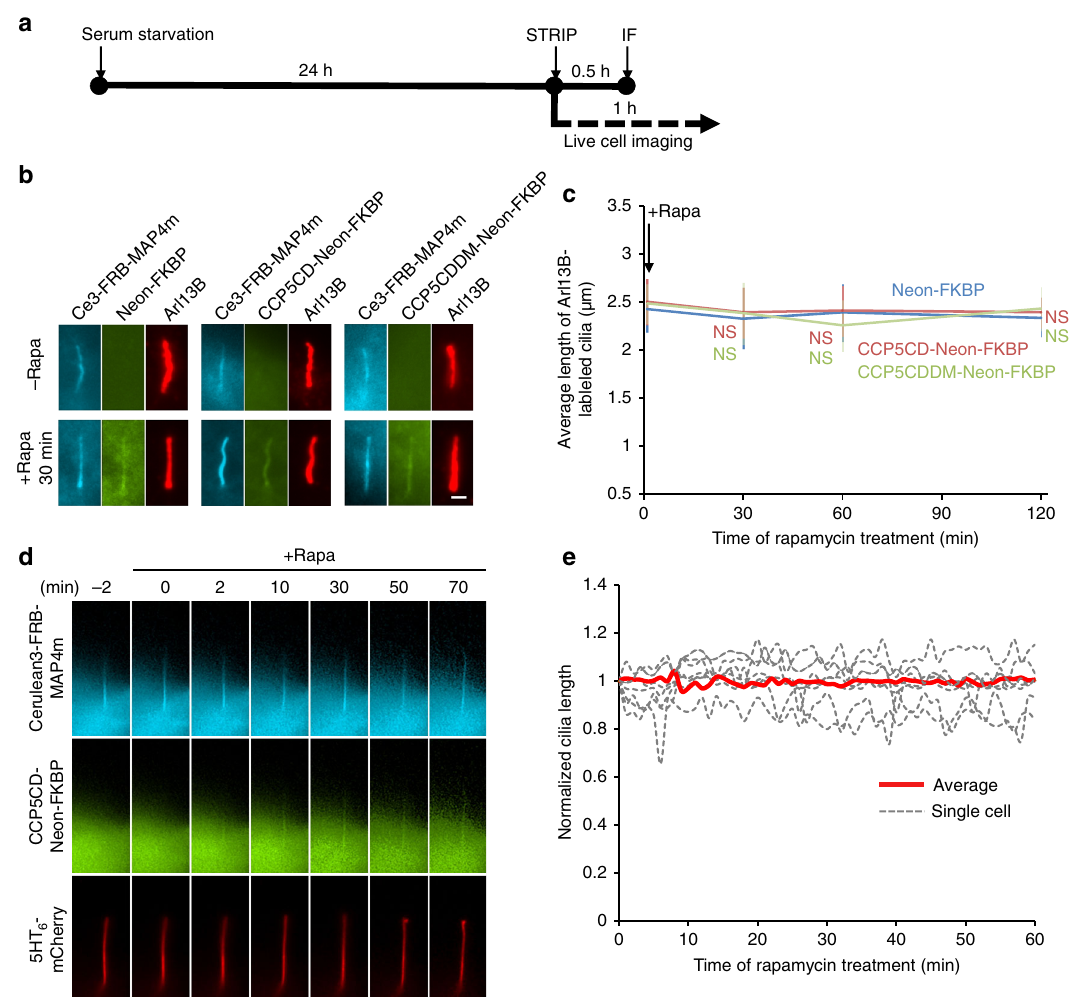
Fig. 2 Glutamylation is not required for cilia maintenance. a The experimental procedure for applying STRIP together with immuno fl uorescence staining (IF) in b or live-cell imaging in d after serum starvation-induced ciliogenesis. b , c Rapid deglutamylation does not affect ciliary length in the steady state. NIH3T3 cells were transfected with P2A-based constructs for co-expression of Cerulean3 (Ce3) – FRB – MAP4m and Neon-FKBP-tagged proteins. Transfected cells at 80 – 90% con fl uency were serum-starved for 24 h and then incubated with 100 nM rapamycin for the indicated times. The cilium length in cells expressing the indicated proteins was measured by labeling with anti-Arl13B antibody and quantifying before and after the addition of 100 nM rapamycin. Scale bar, 1 μ m. Data represent the mean ± s.e.m. ( n = 269, 282, and 238 cells for the Neon-FKBP, CCP5CD-Neon-FKBP, and CCP5CDDM-Neon-FKBP groups, respectively; 3 – 5 independent experiments). NS indicates no signi fi cant difference between the control (Neon-FKBP) and the indicated groups (Student's t -test). d The real-time morphology of the primary cilium during axonemal deglutamylation. NIH3T3 cells were cotransfected with CCP5CD-Neon-FKBP – P2A – Cerulean3 – FRB – MAP4m and a ciliary membrane marker, 5HT 6 – mCherry. Transfected cells at 80 – 90% con fl uency were serum-starved for 24 h and then incubated with 100 nM rapamycin for the indicated times. Video frames of a cell coexpressing the indicated proteins upon treatment with 100 nM rapamycin are shown. Scale bar, 4 μ m. Also see Supplementary Movie 4. e The length of 5HT 6 – mCherry-labeled cilia in d was normalized by dividing the measured length by the length measured before rapamycin treatment and plotted. Red curves and gray dot curves show the average length and the length of each cilium during deglutamylation, respectively ( n = 7 cilia from four independent